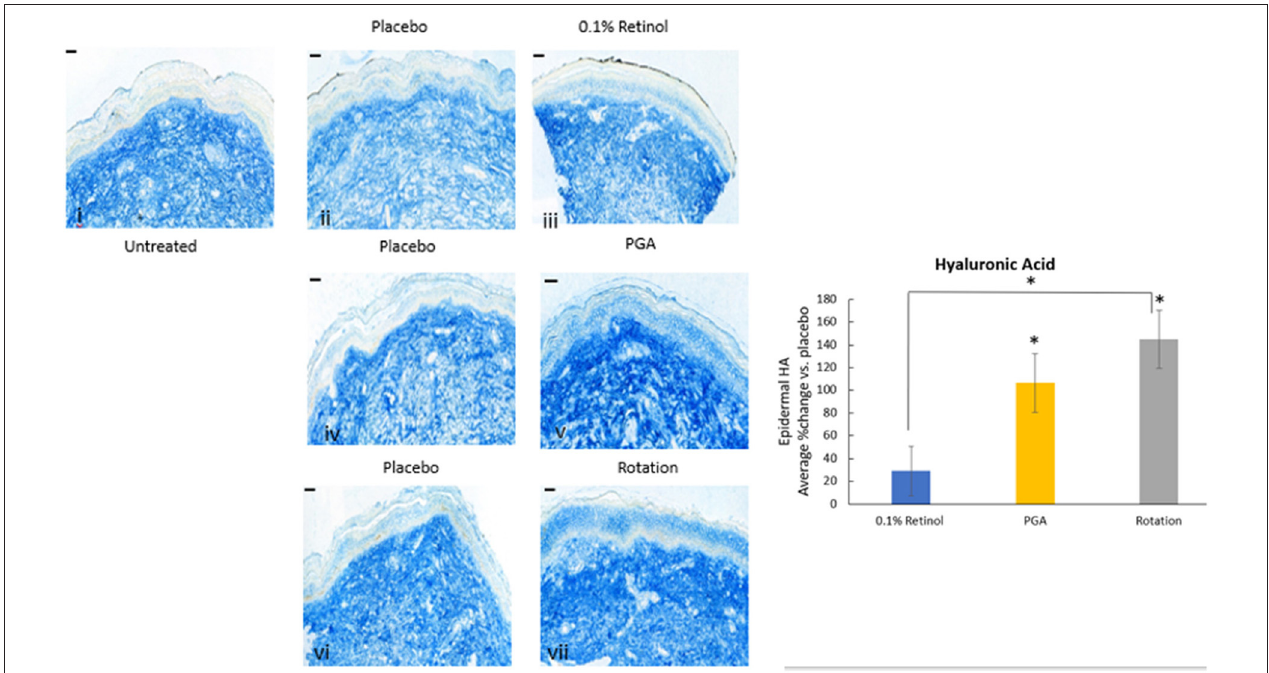
FIGURE 8 | Immunohistology of skin biopsies. Volunteers ( n = 32) received application of either 0.1% retinol formulation for 4 weeks or weekly rotation of 1% phytol/4% glycolic acid (PGA) formula with 0.1% retinol formula. Biopsy samples were taken at the end of the 4-week period. An analysis of epidermal hyaluronic acid in in vivo skin samples via HABP staining was performed. Rotational treatment was superior to retinol alone and better than the PGA formula ( p < 0.05). i: untreated, ii: placebo for retinol, iii: retinol, iv: placebo for PGA, v: PGA, vi: placebo for vii, and vii: rotation of iii and v. Scale bar = 50 µ m. *Means p < 0.05 or statistically significant result.